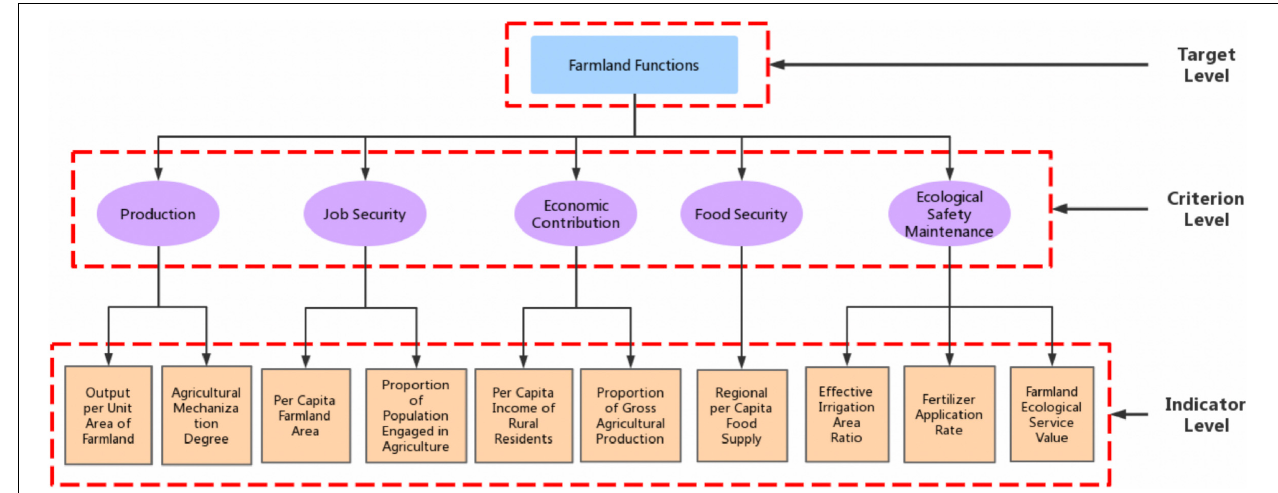
FIGURE 3 | Description of cultivated land system function evaluation